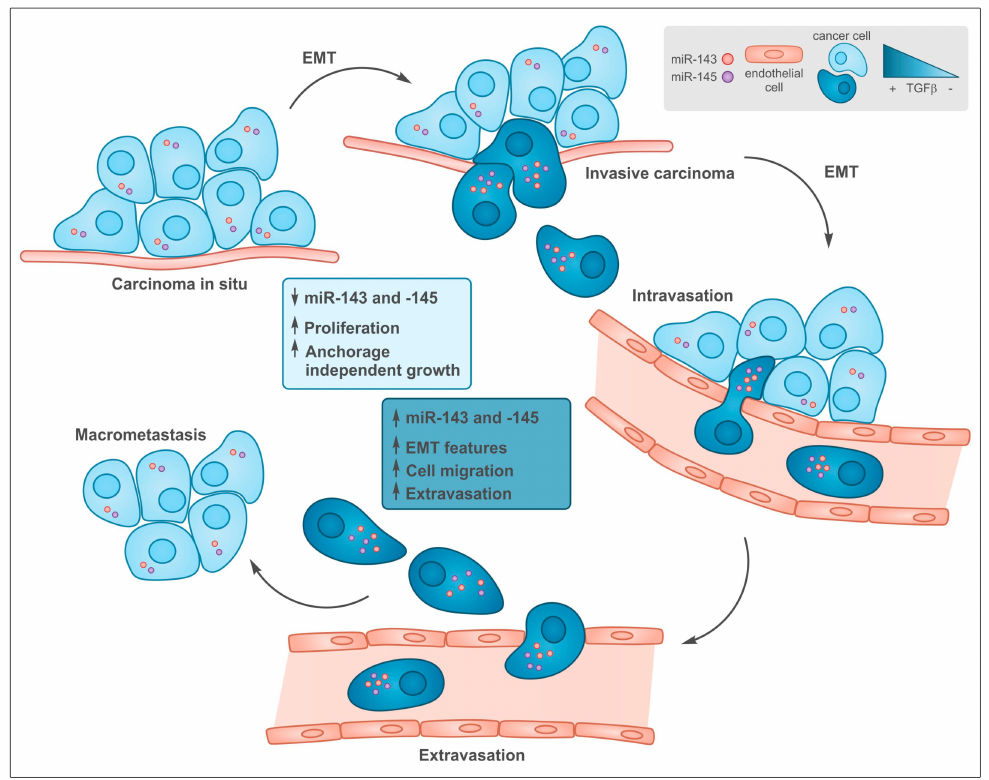
Figure 2. Common functions of transforming growth factor beta (TGF- β ) and miR-143 and -145 during tumor progression. In early stages low levels of both TGF- β and miR-143 / 145 are required to allow cell proliferation at the primary sites. During tumor progression, some cells undergo epithelial to mesenchymal transition (EMT), which is induced by TGF- β that, among many other targets, triggers the up-regulation of miR-143 and -145 expression, which in turn, support tissue invasion and metastasis